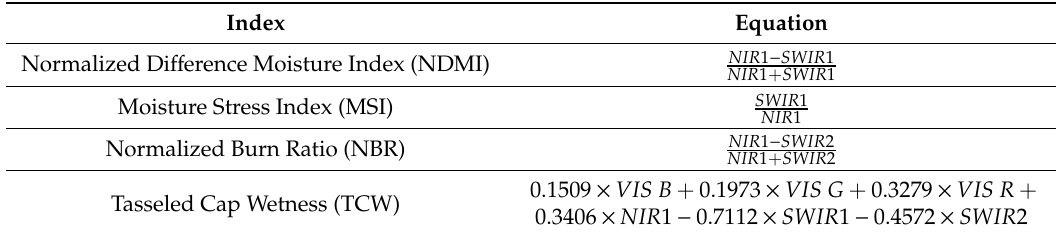
Table 1. Indices used in the study (NIR—Near Infrared, SWIR—Short wave infrared, VIS B—visible blue, VIS G—visible green, VIS R—visible red).